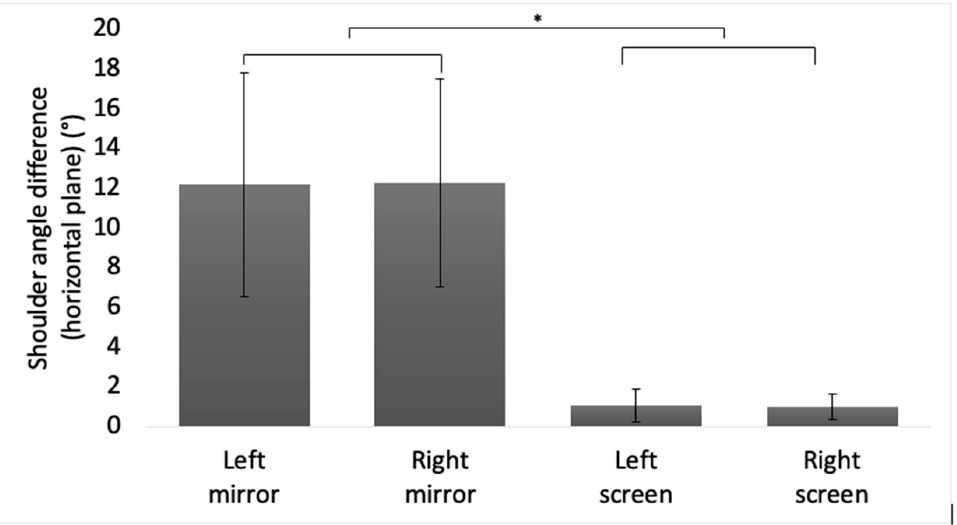
Figure 7. This bar chart shows shoulder angle difference (horizontal plane) during intervention in mirror and screen con- ditions. Asterisks represent statistical significance ( p <